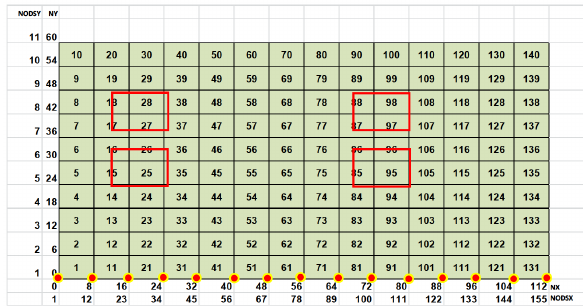
Figure 7: Slab design, wheel configuration in KENSLAB, and the highest stress position in each row of